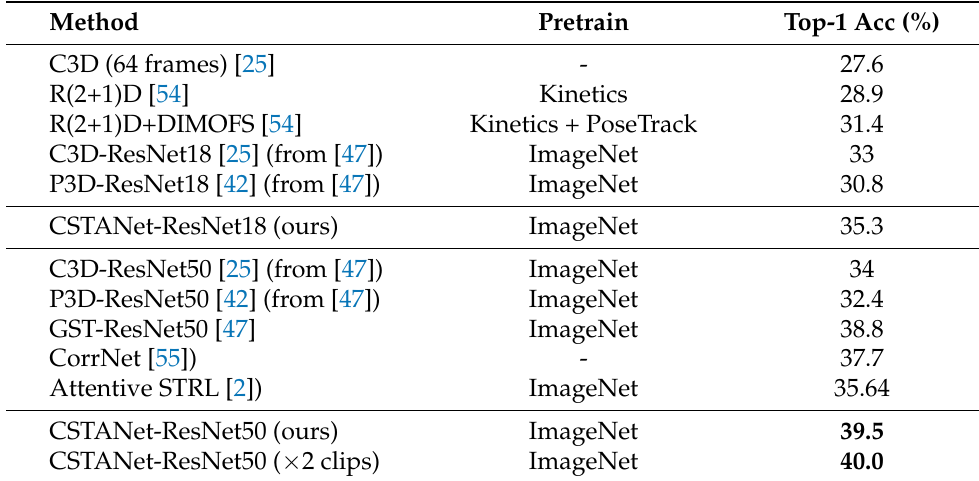
Table 5. State-of-the-art results on Diving48.